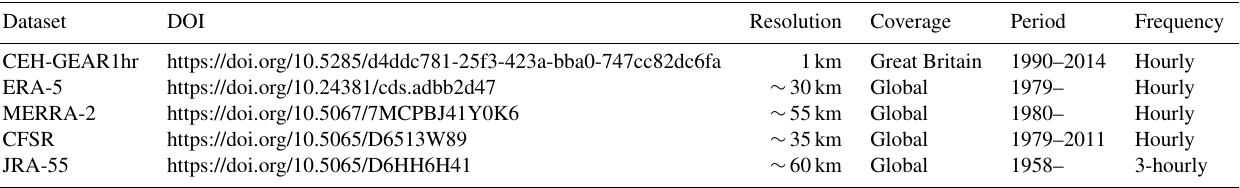
Table 1. Precipitation products included in this study. Where the end of the period is not given, the product continues to be updated to the present day at the time of